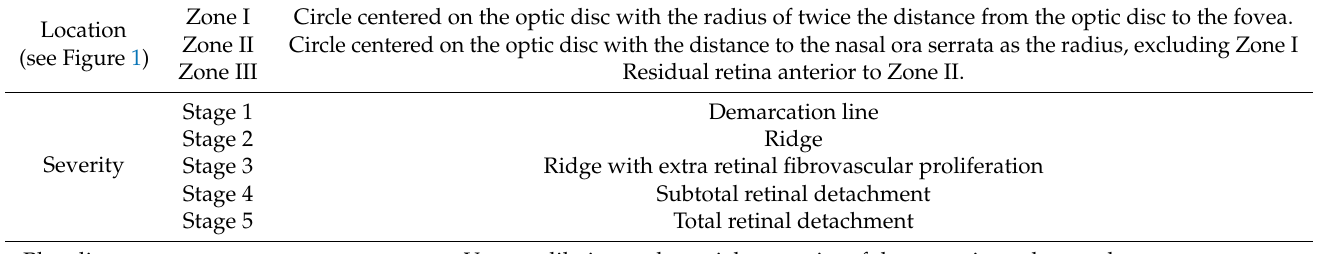
Table 1. The classification of retinopathy of prematurity